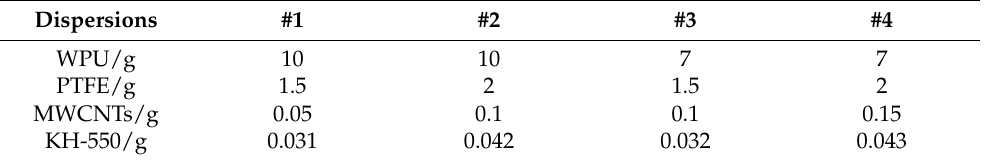
Table 1. Samples of the mixed WPU dispersions with modified fillers.